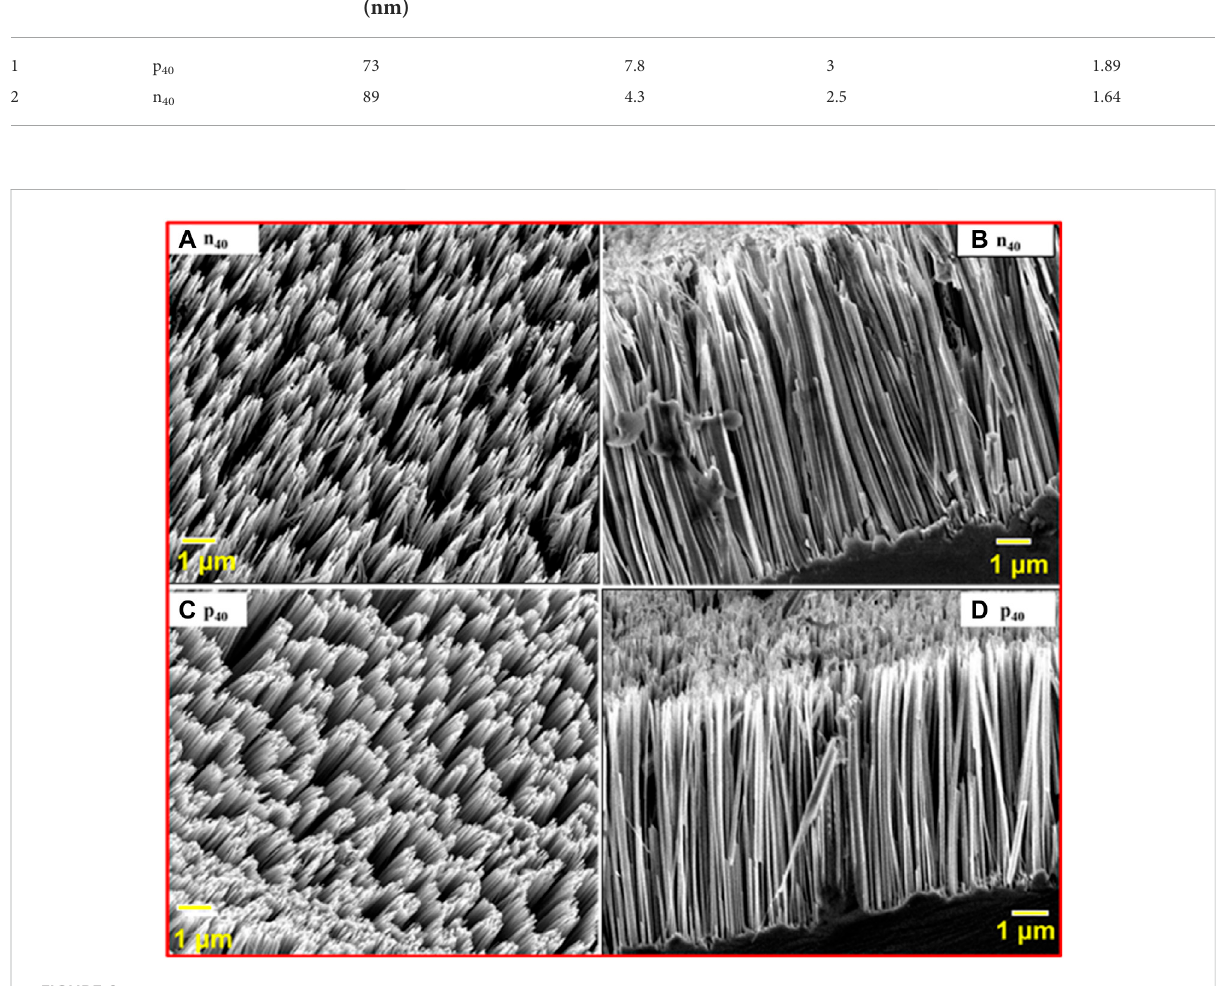
FIGURE 2 45 o -tilt view and cross-sectional FESEM images of samples (A,B) for the n 40 Si NW (C,D) and p 40 Si NW,